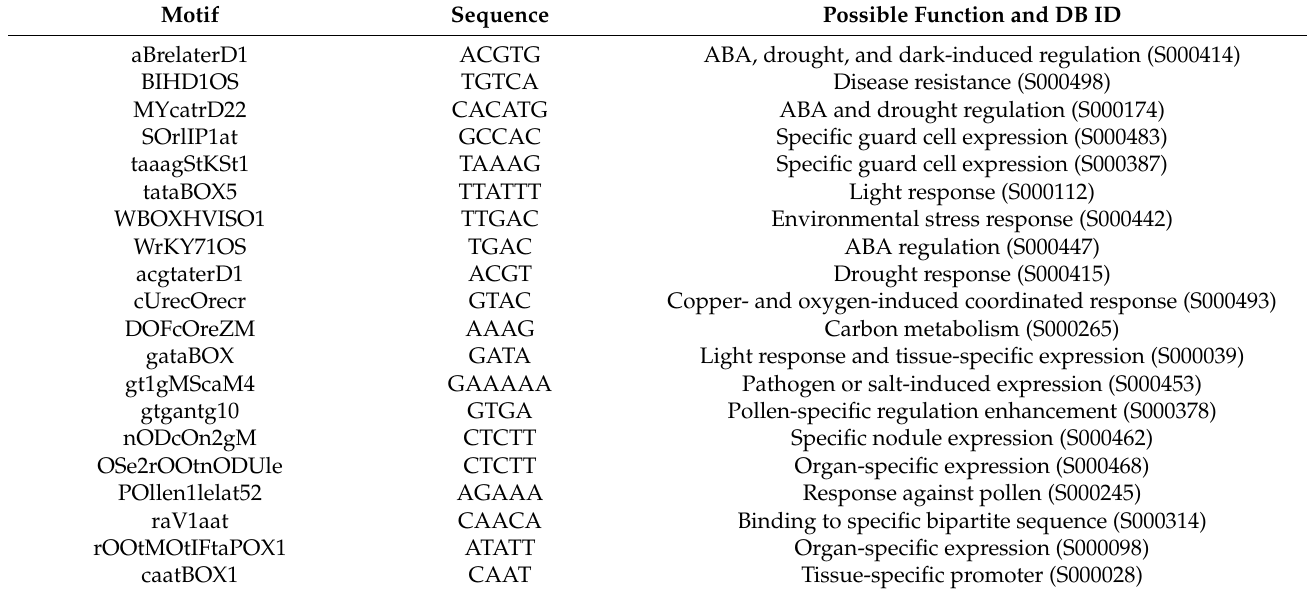
Table 1. Proposed motifs in 2 kb upstream region of transcription start site in PHO1 of Zea mays , Oryza sativa , Hordeum vulgare , Triticum aestivum , and Arabidopsis thaliana